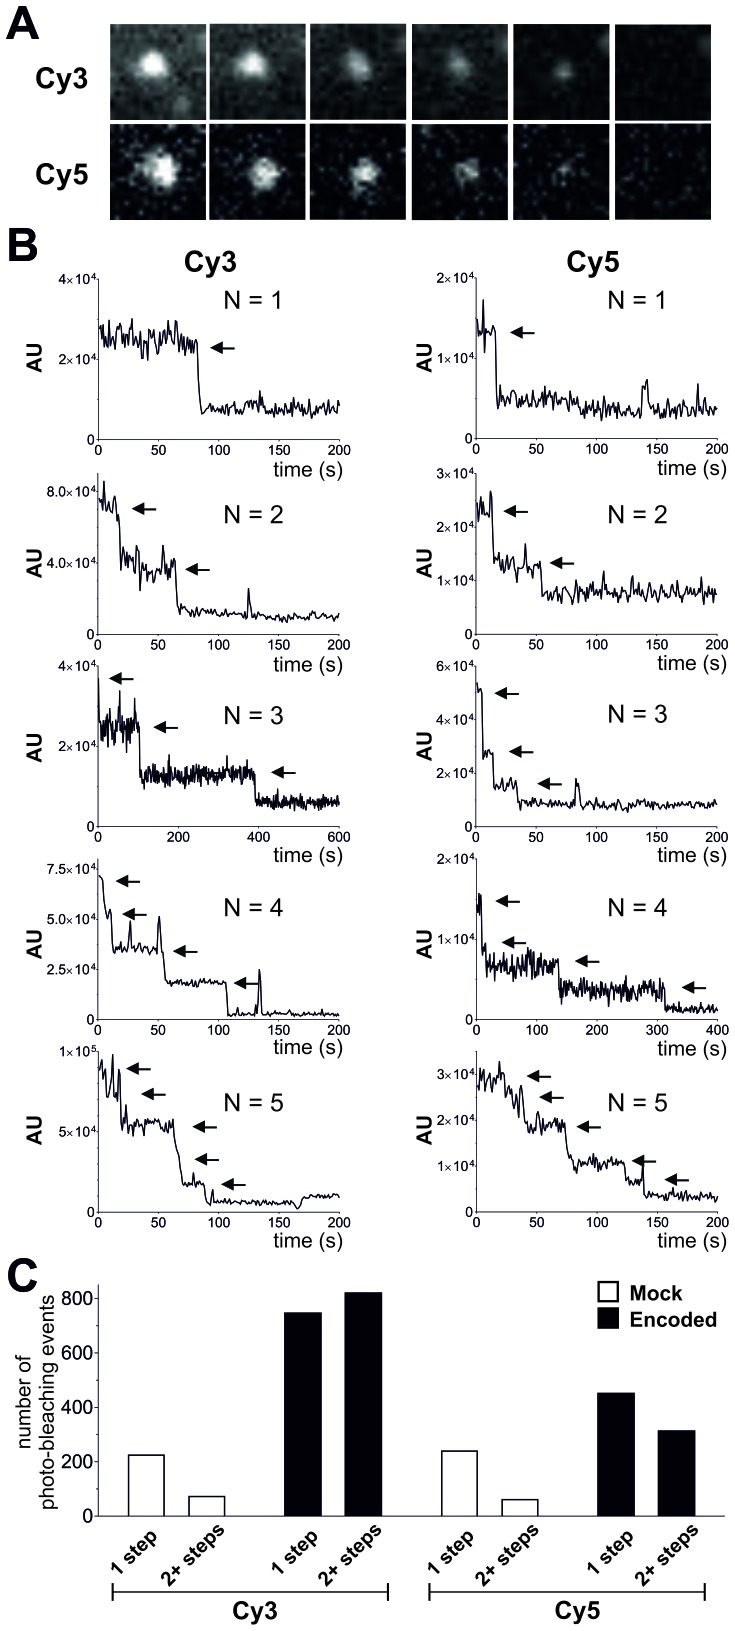
Photo-bleaching profiles for Cy3 and Cy5 spots in Encoded and Mock conditions.(A) and (B) Photo-bleaching events of Cy3 and Cy5 fluorescent spots in the Encoded sample. (A) Example of a 5-step photo-bleaching event of a fluorescent spot showing Cy3 (top) or Cy5 fluorescence (bottom), respectively, in an oocyte co-injected with ClC-0 E166TAG cRNA as well as Cy3- and Cy5-tRNA. A single representative frame was selected from the video sequence showing step-wise reduction in spot-intensity. Presented area size is 20 pixels x 20 pixels. (B) Examples of fluorescence traces (in arbitrary units, AU) as a function of time show step-wise photo-bleaching for Cy3 (left) and Cy5 (right), respectively, until complete photo-destruction of the fluorophore was achieved. Arrows indicate observed steps during the bleaching process; N is equal to the total number of identified steps. (C) Photo-bleaching histogram for Cy3 and Cy5 spots in Encoded and Mock reveal a distribution distribution of steps: while in Mock 1-step events strongly dominated, in Encoded the distribution was clearly shifted towards 2+ steps. Values represent absolute numbers for the identified bleaching step event analyzed from an equal number of frames for each condition (five oocytes, three batches). In total, following numbers were included: N = 1564 for encoded Cy3, N = 762 for encoded Cy5, N = 296 for mock Cy3, N = 300 for mock Cy5.